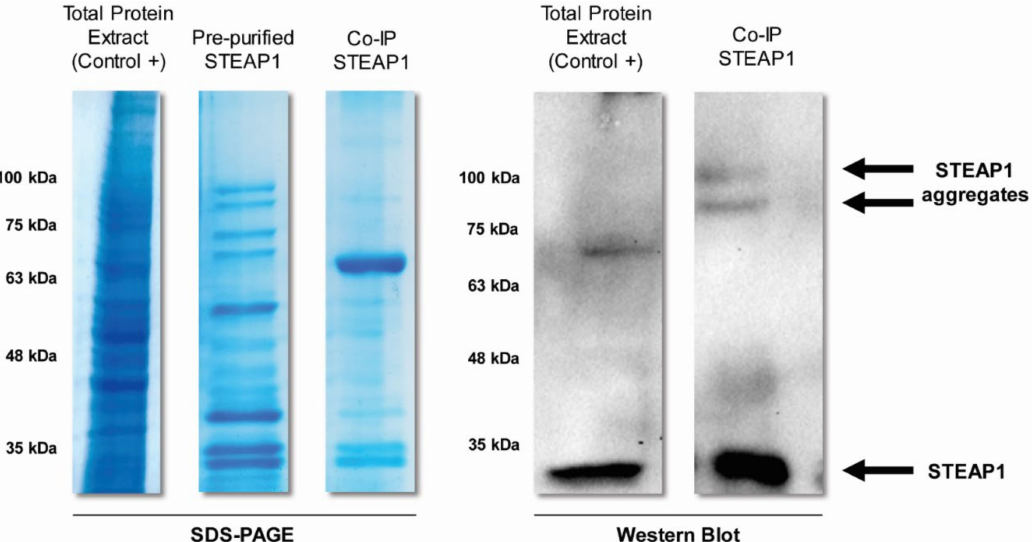
Figure 2. SDS-PAGE and WB analysis of STEAP1 and its aggregates obtained in each step of the overall bioprocessing: the initial total protein extract from LNCaP cells, the pre-purified sample from Butyl-Sepharose 4FF and the final co- immunoprecipitated extract. The gel was stained with Coomasie brilliant blue and the membranes were incubated with anti-STEAP1 mouse primary antibody overnight at 4 ◦ C followed by goat anti-mouse secondary antibody incubation at room temperature.